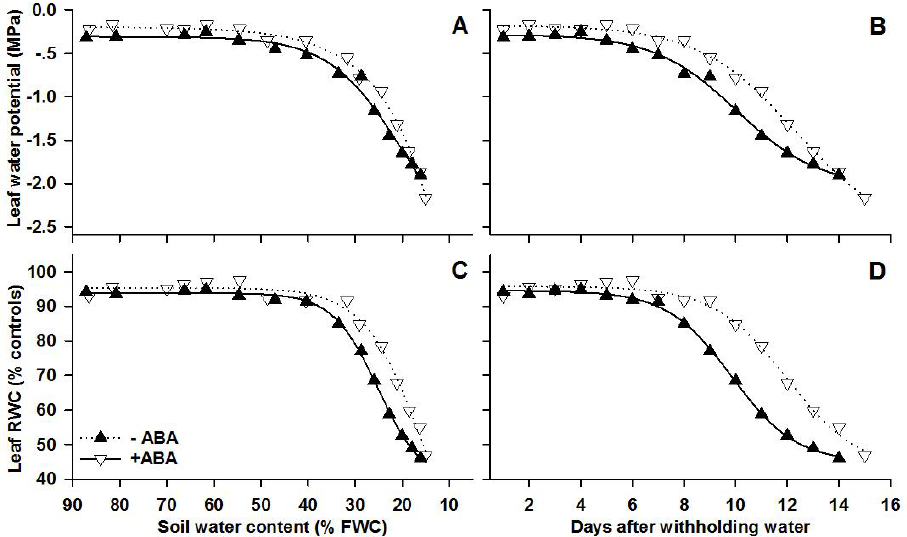
Figure 4. Changes in leaf water potential (LWP) and leaf relative water content (RWC) with soil water content ( A , C ) and days after withholding water ( B , D ) in the soybean cultivar Jindou 19 (JD). One day before withholding water, plants were pretreated with (+ABA) or without (−ABA) 10 µM exogenous ABA. Values are means ± SE ( n = 3).